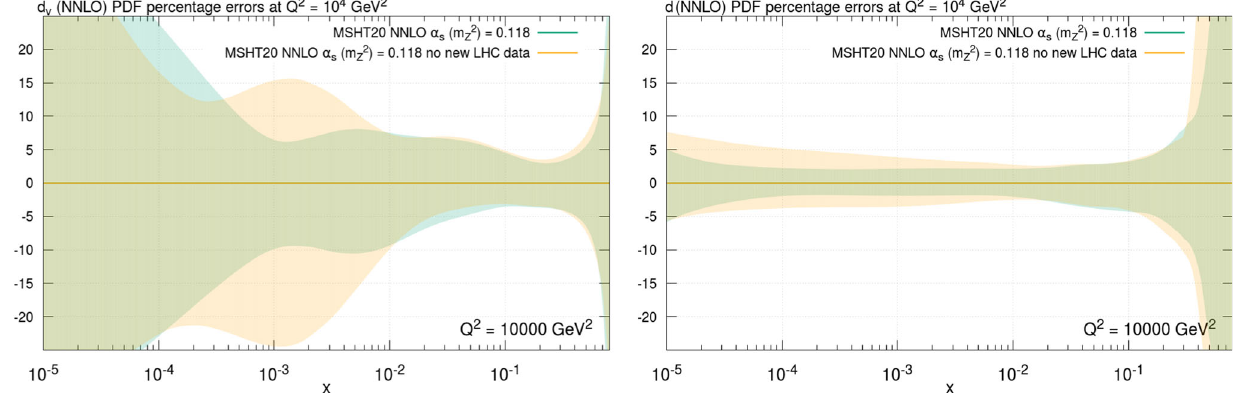
Fig. 52 (Left) Down valence and (right) down antiquark PDF percentage errors upon removal of the new LHC data compared to MSHT20 at Q 2 = 10 4 GeV 2 at